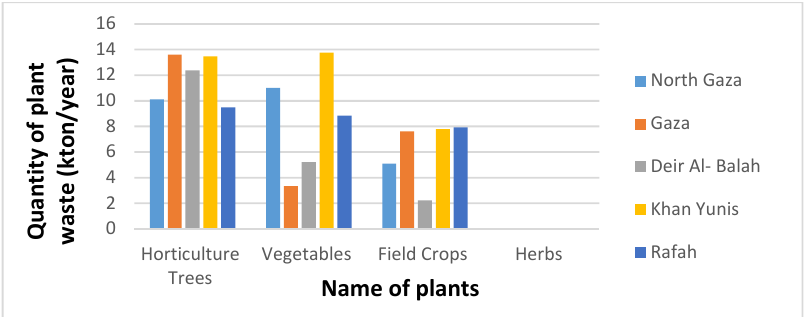
Figure 5. Agricultural plant waste produced in each Governorate.